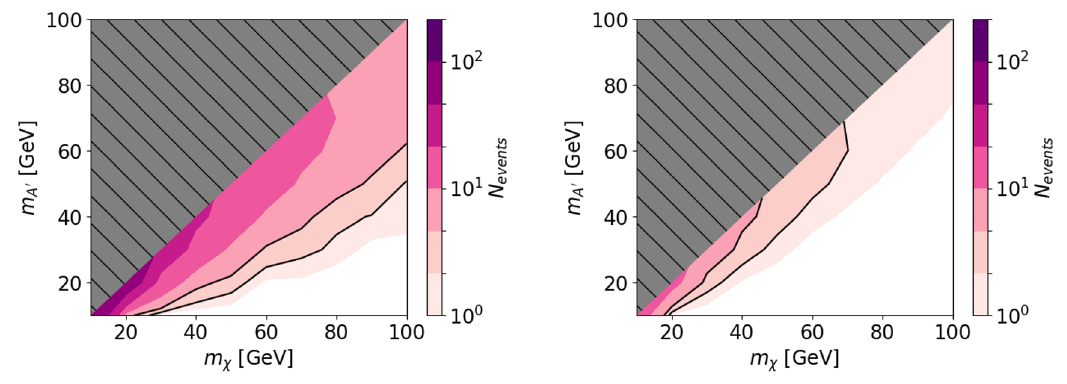
Figure 9. The expected number of events observable by GAPS over the parameter space of DPDM model assuming MAX (left) and MED (right) cosmic ray propagation. A NFW pro(cid:12)le as in eq. (5.3) and coalescence momentum of p 0 = 150 MeV are assumed. The contours represent 3 (cid:27) ( N = 2) and 5 (cid:27) ( N = 4) detection thresholds respectively. Our chosen benchmark model predicts a > 5 (cid:27) detection in the most optimistic scenario and a 2 (cid:0) 3 (cid:27) detection in the most